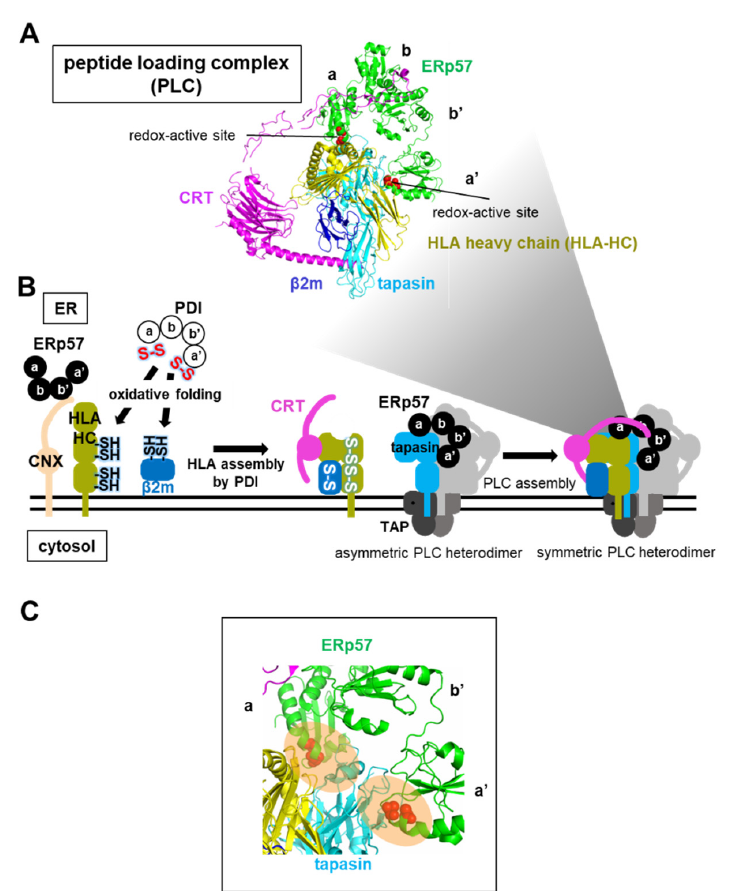
Figure 8. ERp57-assisted HLA and peptide loading complex (PLC) complex formation. ( A ) Cryo-electron microscopy structure of PLC composed of ERp57, CRT, HLA-HC, β 2m, and tapasin, colored green, magenta, yellow, blue, and cyan, respectively (PDB code: 6ENY). ( B ) Schematic diagram of the folding and assembly pathway of HLA and PLC. CNX with ERp57 recognizes HLA-HC through monoglucosylated N-linked glycans, and PDI then catalyzes disulfide bond formation of HLA-HC and β 2m, and HLA assembly. The HLA heterodimer is recruited to the asymmetric PLC heterodimer by CRT, resulting in the formation of the symmetric PLC heterodimer. ( C ) Close-up view of the complex interface between redox-active sites of a and a’ domains in ERp57 and tapasin (PDB code: 6ENY). Redox-active sites are shown as red spheres.